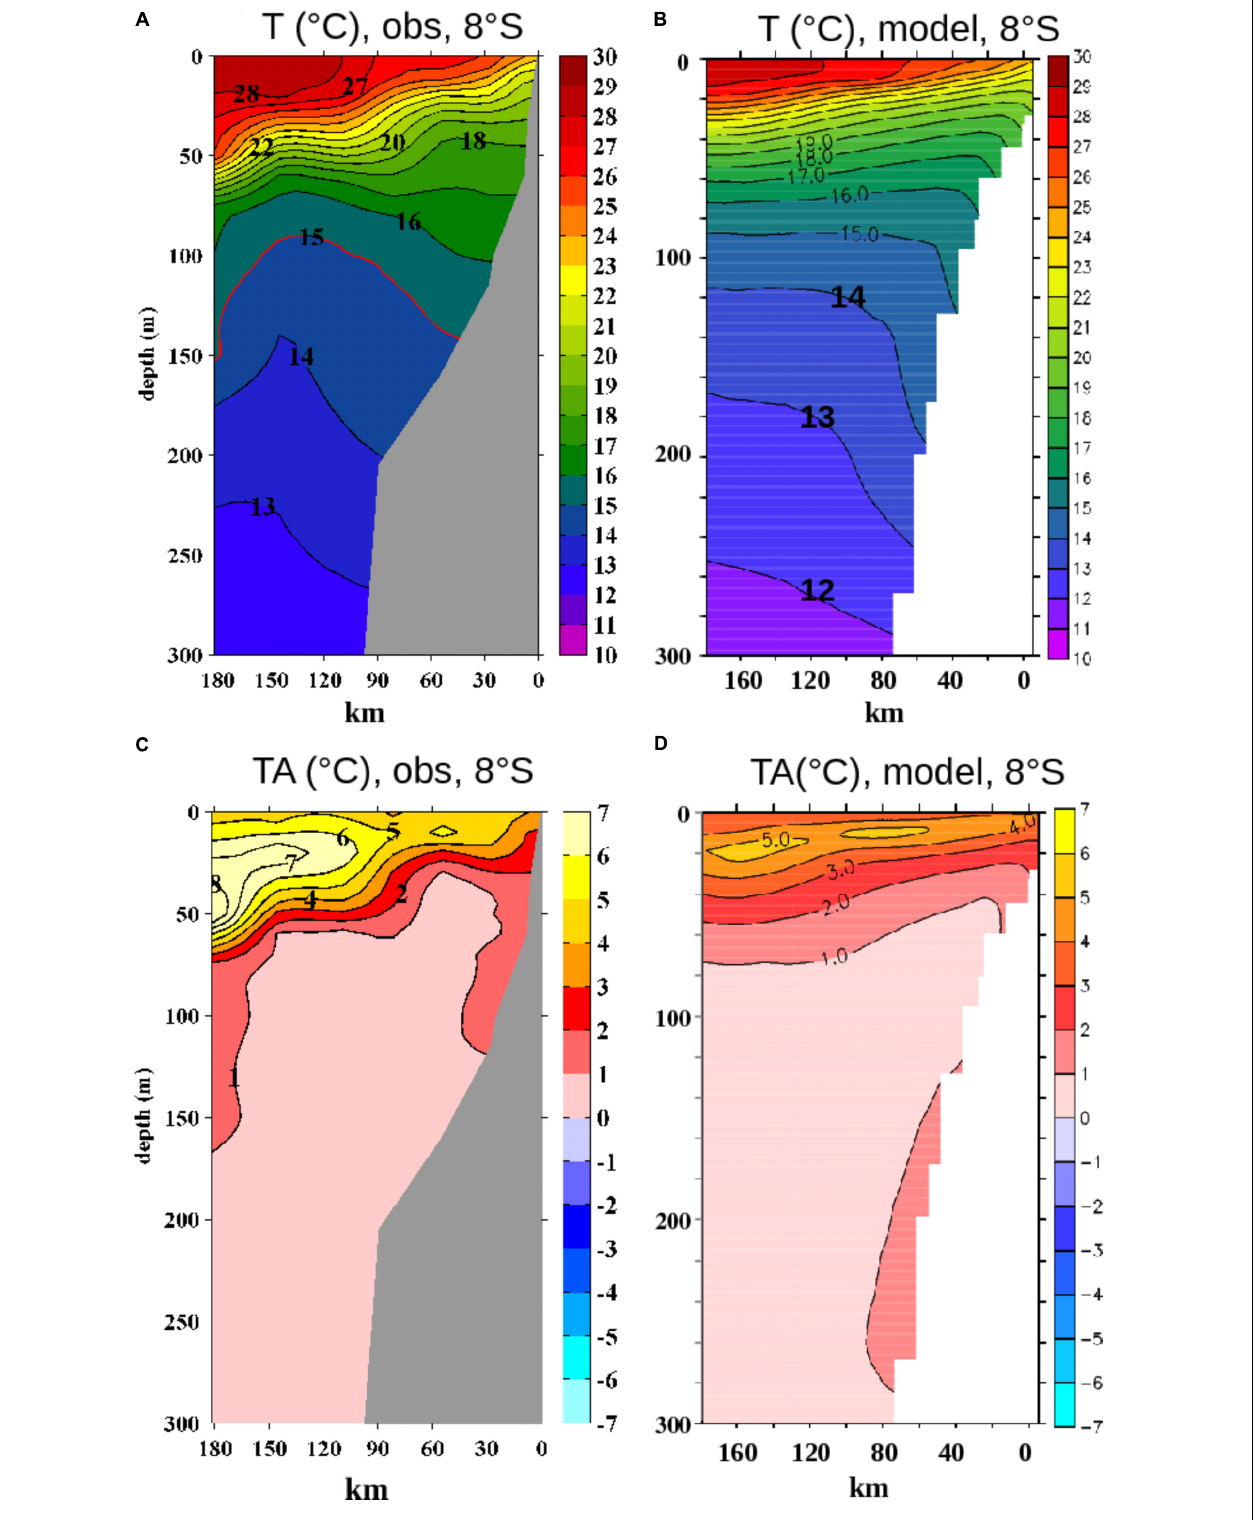
FIGURE 5 | Cross-shore vertical sections of temperature (A,B) absolute values and (C,D) anomalies (in ◦ C) in March 2017 off the northern Peru shelf (Chicama, 8 ◦ S). The section’s location is indicated in Figure 4C . Observed anomalies (c) were computed with respect to a climatology of IMARPE data for the period 1981–2010, while modeled anomalies were computed with respect to a model climatology for 2013–2016.